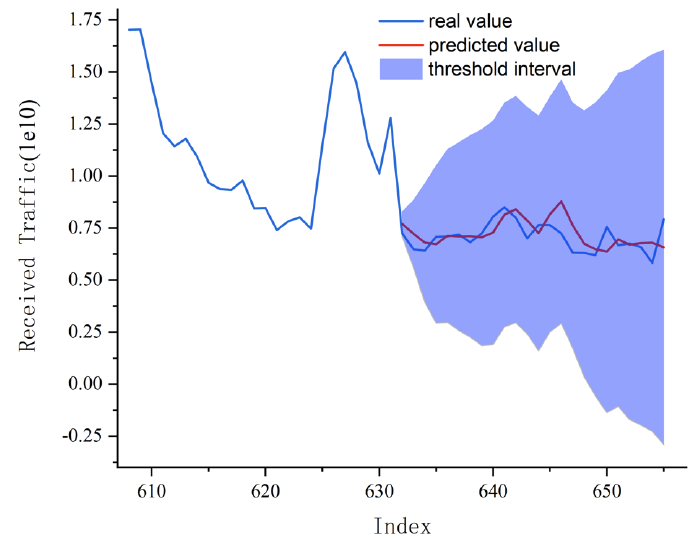
Figure 13. Dynamic threshold interval diagram.